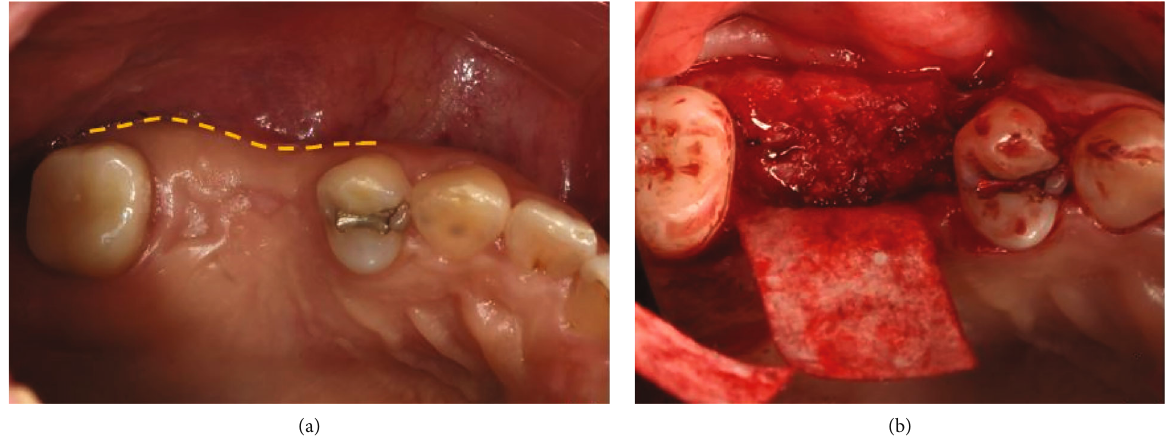
Figure 10: Intraoral views of the alveolar ridge splitting technique with guided bone regeneration (Case 3). (a) Pre-operative site of gingiva. (b) Alveolar bone splitting and expanding with chisel and GBR were done.